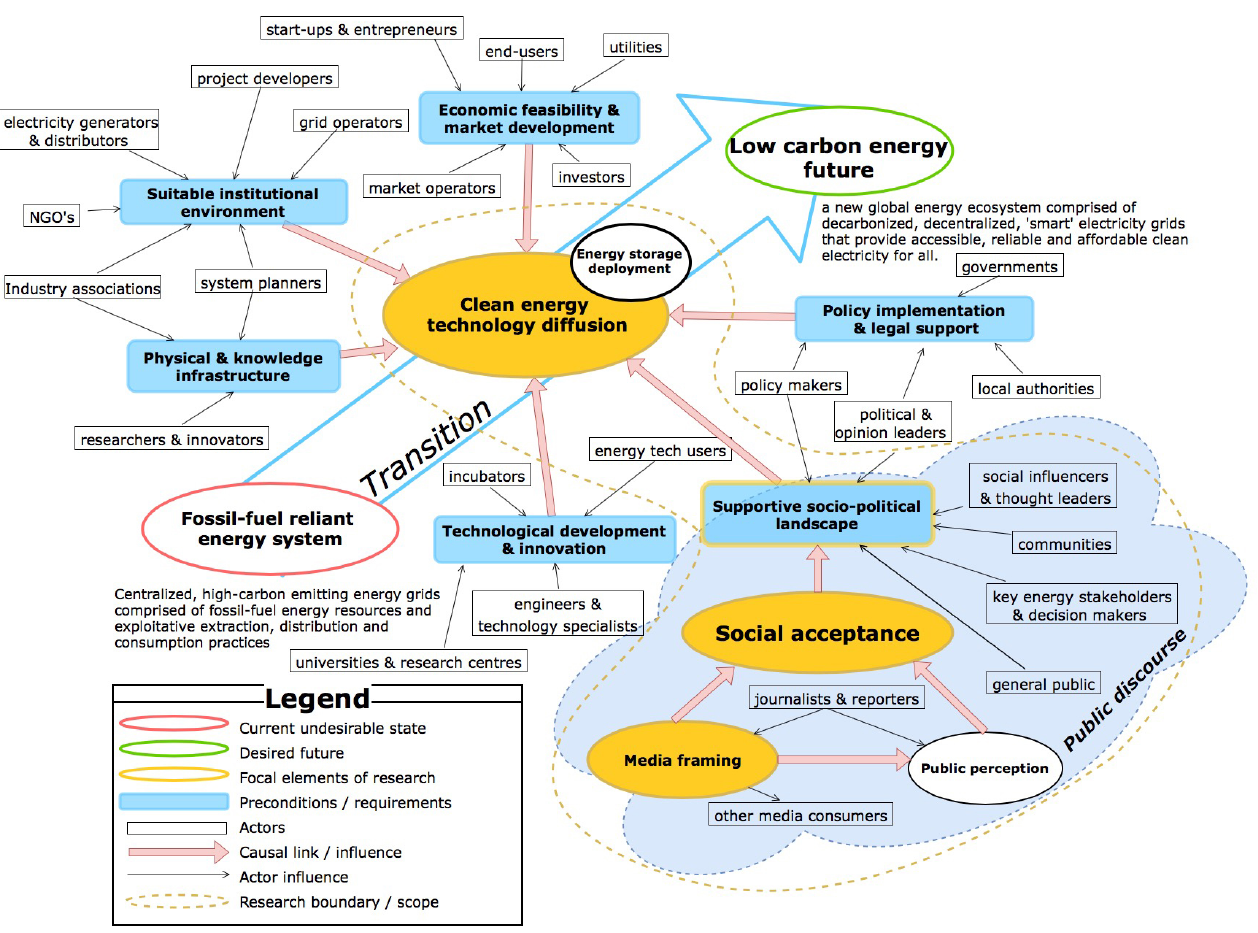
Fig. 2. Example theory of change: change for a low-carbon energy future (S.